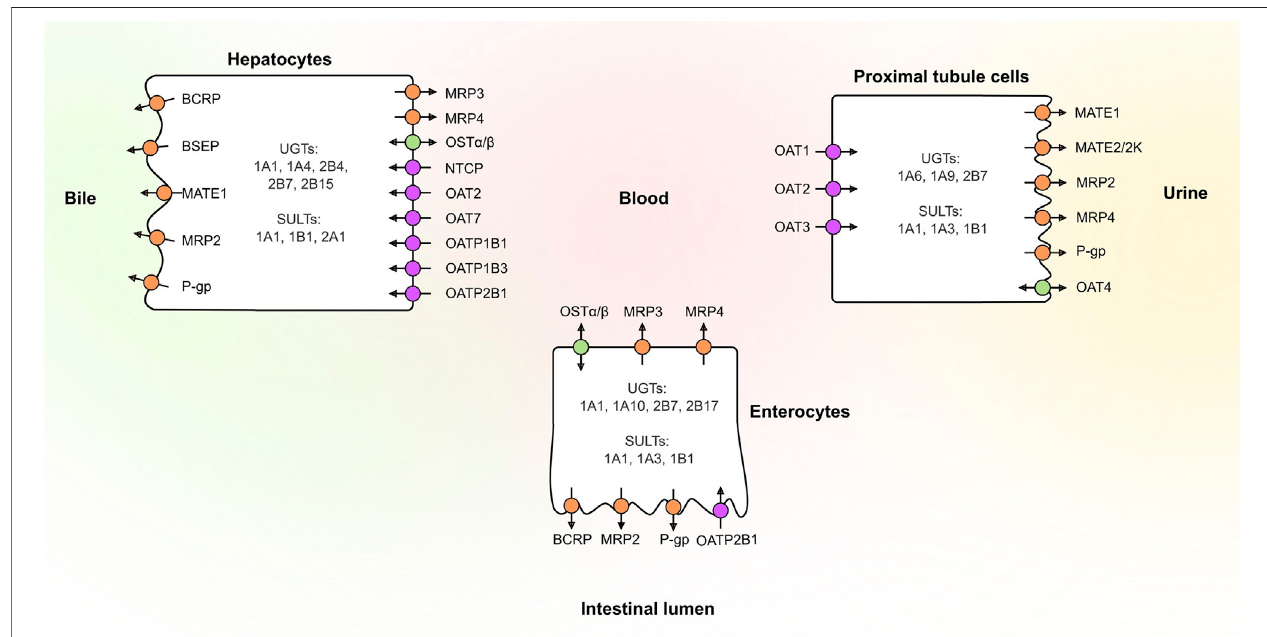
FIGURE1 | Localization ofthe main drug transporters in the human liver, kidney and intestineas well asthe main phase IIenzymesinvolved inglucuronidation and sulfation reactions of drugs. Uptake transporters are colored in purple, ef fl ux transporters in orange, and bidirectional transporters in green. BCRP, breast cancer resistance protein; BSEP, bile salt export pump; MATE, multidrug and toxin extrusion protein; MRP, multidrug-resistance associated protein; NTCP, sodium/ taurocholate cotransporting polypeptide; OAT, organic anion transporter; OATP, organic anion transporting polypeptide; OST α / β , organic solute transporter α / β ; P-gp, P-glycoprotein; SULT, sulfotransferase; UGT, uridine 5 ′ -diphospho-glucuronosyltransferase.